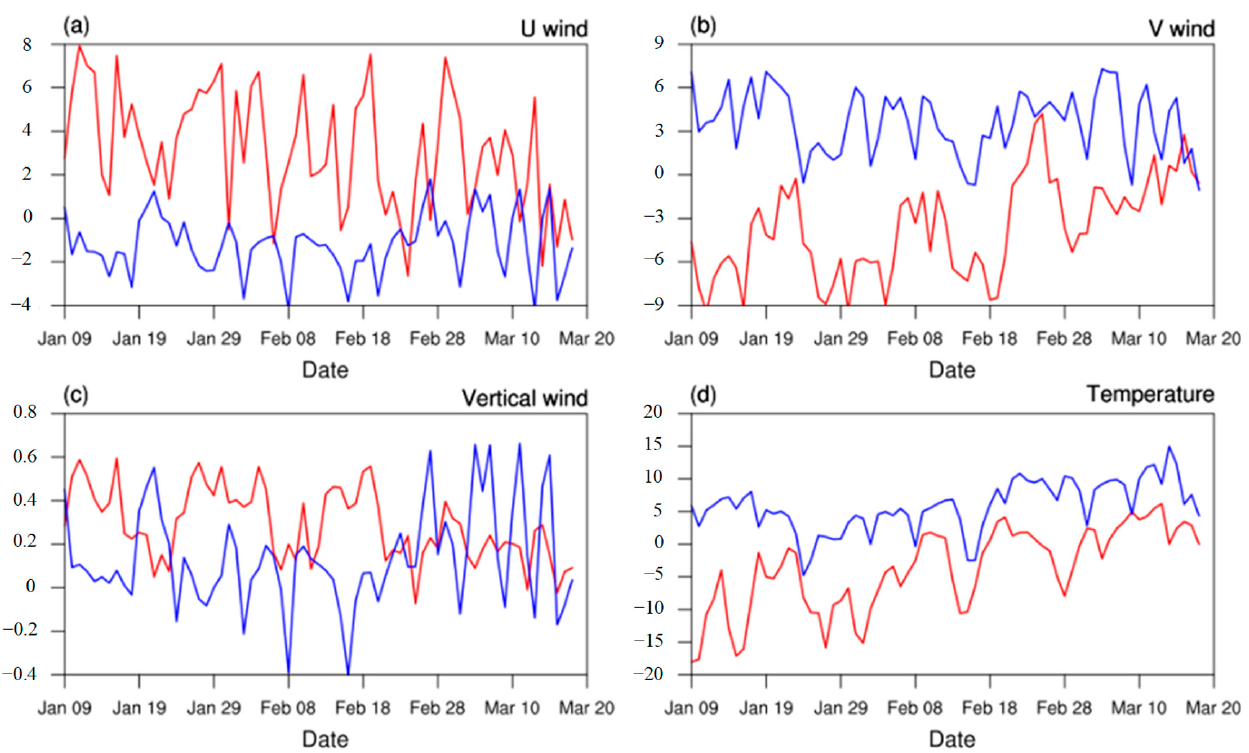
Figure 1. Eddy covariance observation system at ( a ) site 1 and ( b ) site 2.